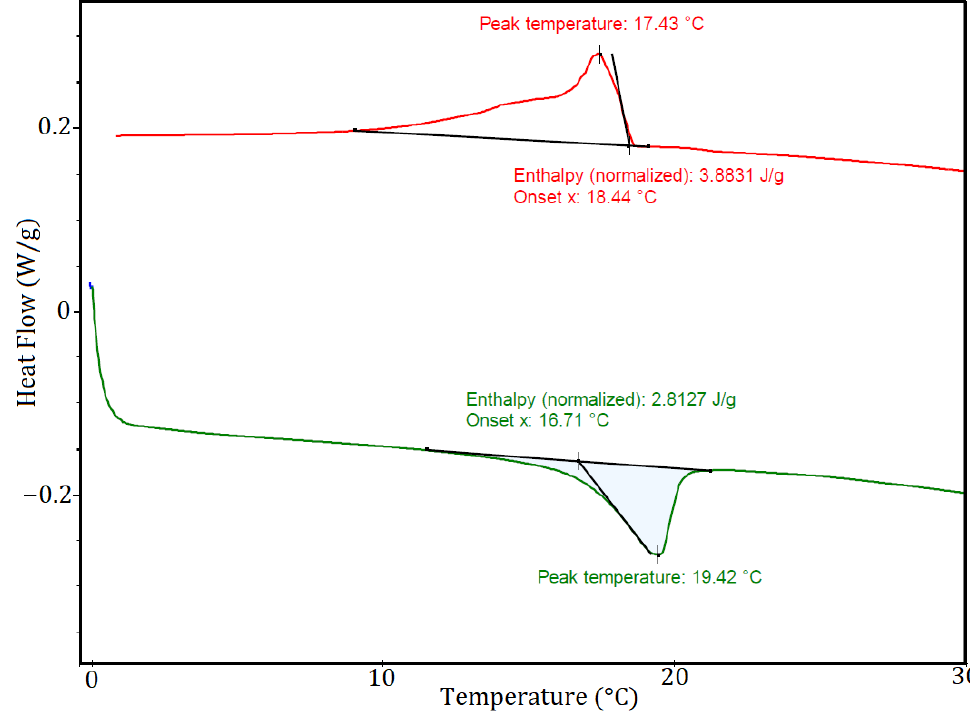
Figure 3. Melting (green) and solidifying (red) DSC curves of the PCM-modified wood (PCMW).